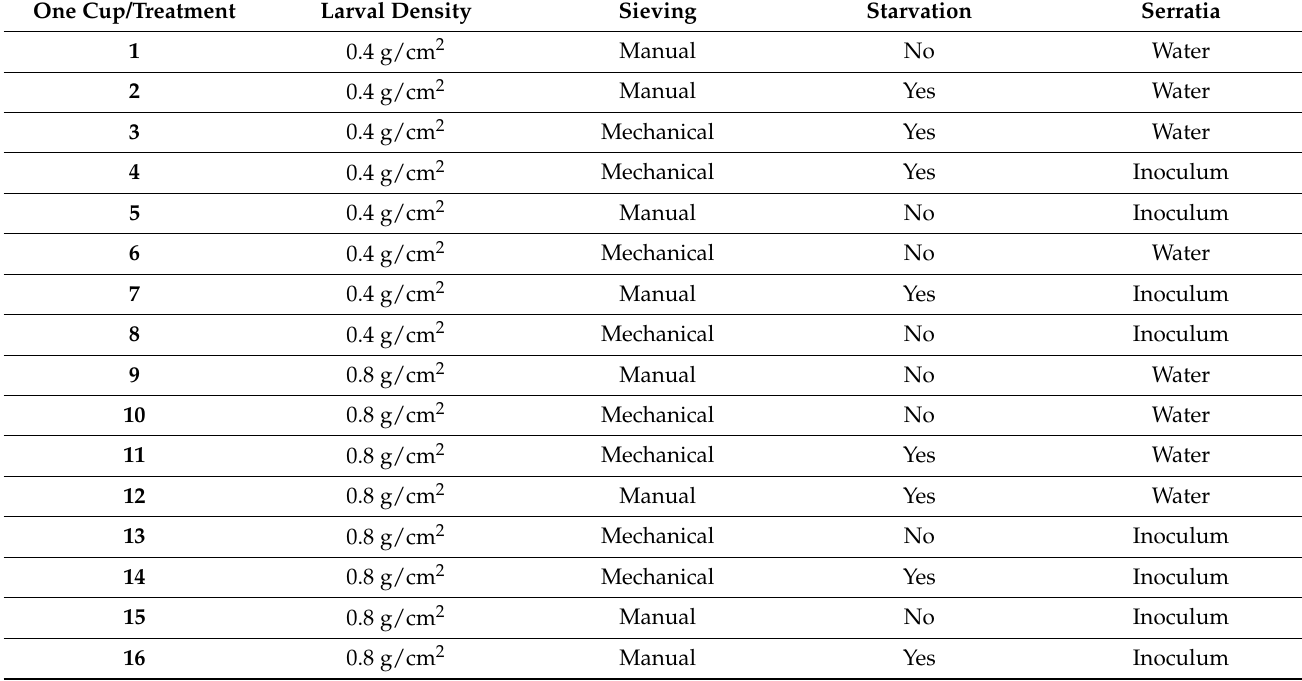
Table 1. Experimental design description for each of the 16 treatment